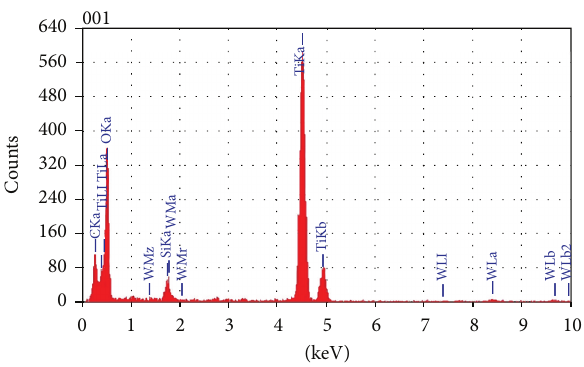
Figure3:CrosssectionSEMofaTiO 2 filmonc-Si.Theimageshows a columnar structure with voids.